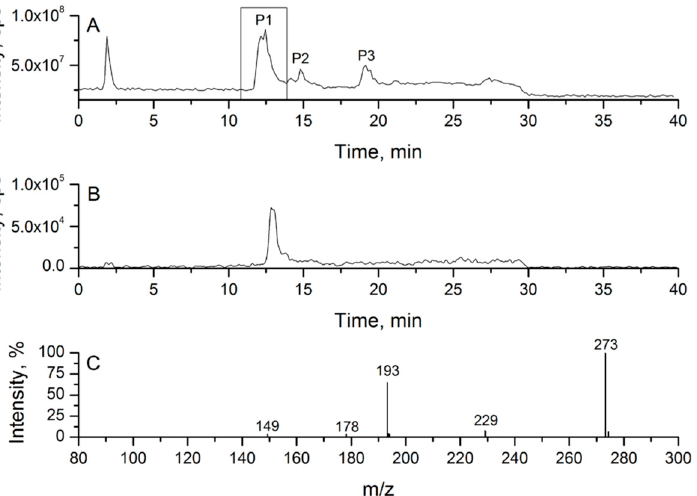
Figure 2. ( A ) TIC of mixture after synthesis of ferulic acid-4- O -sulfate; ( B ) chromatogram of ferulic acid-4- O -sulfate obtained after purification; ( C ) fragmentation spectra of ferulic acid-4- O -sulfate.